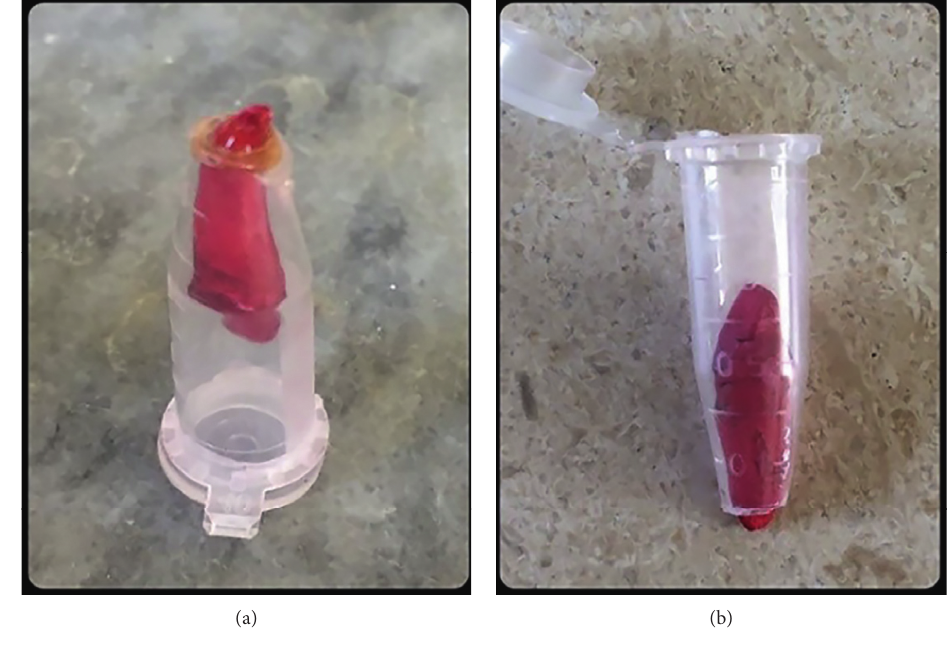
Figure 1: Sealing the gap between sample and tube.